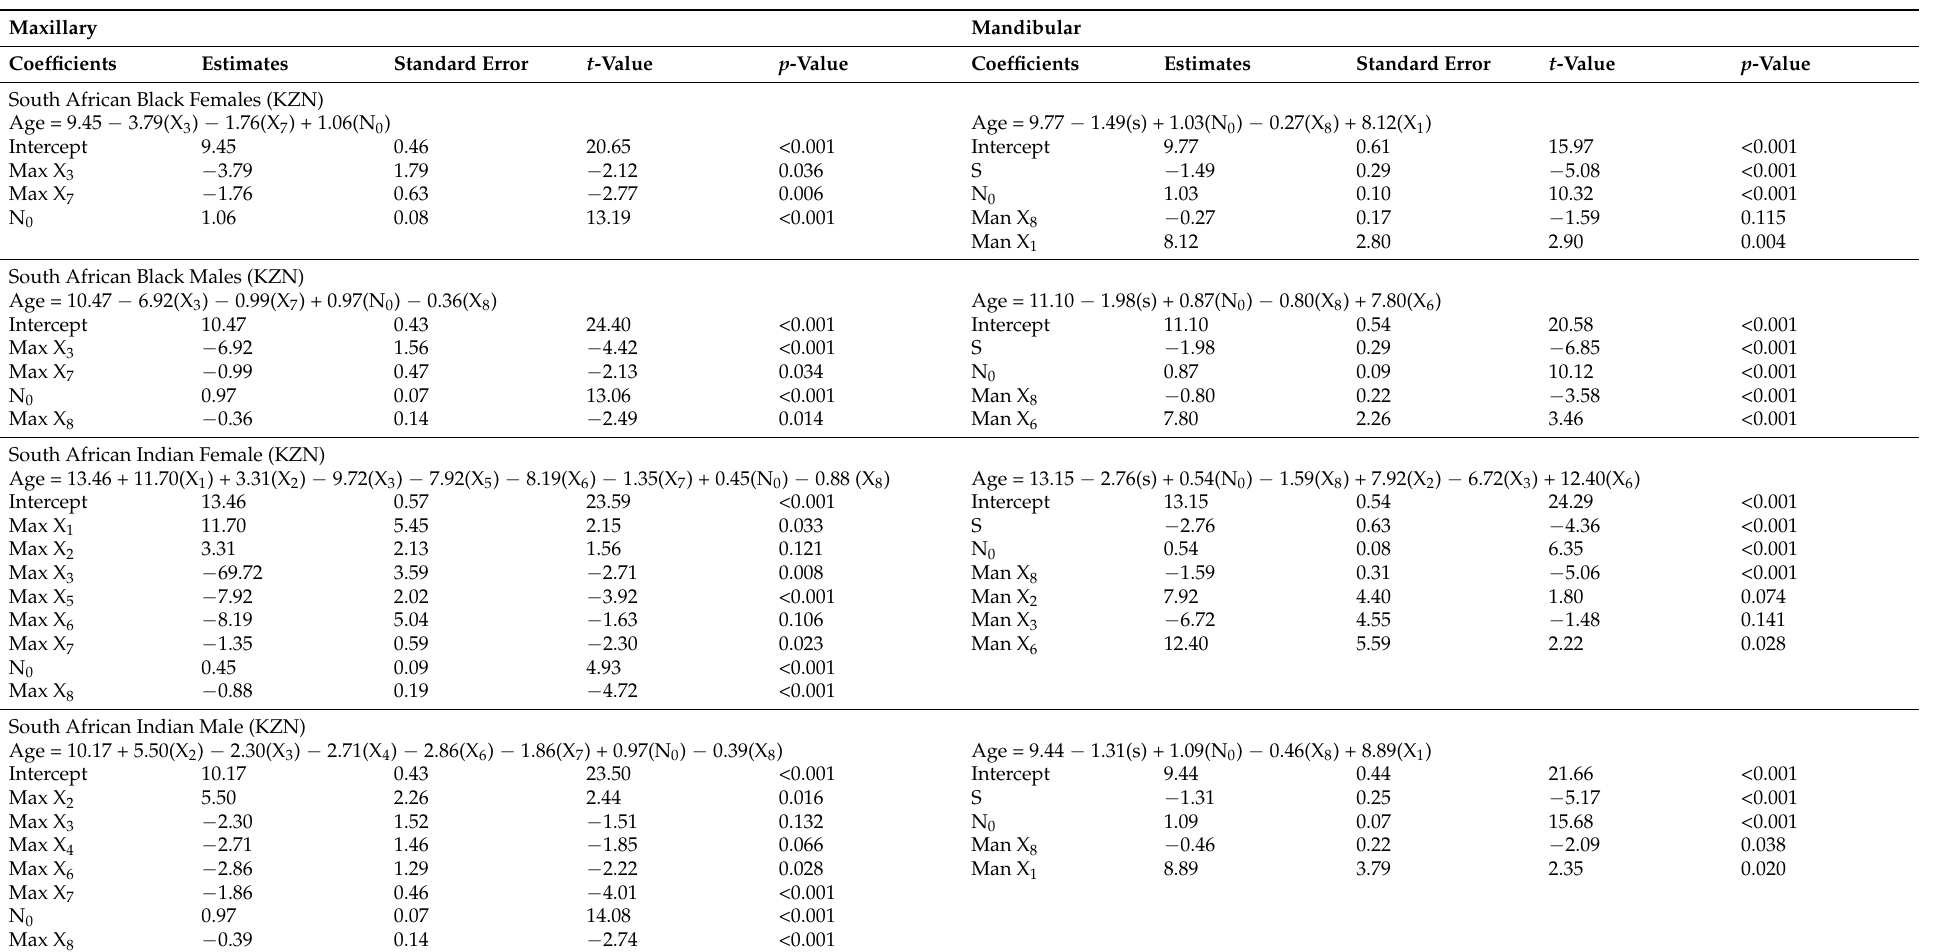
Table 5. Estimation of chronological age using step-wise regression analysis for South African Black and Indian population groups of KZN in individuals aged between 5.00 and 19.99 years (including third